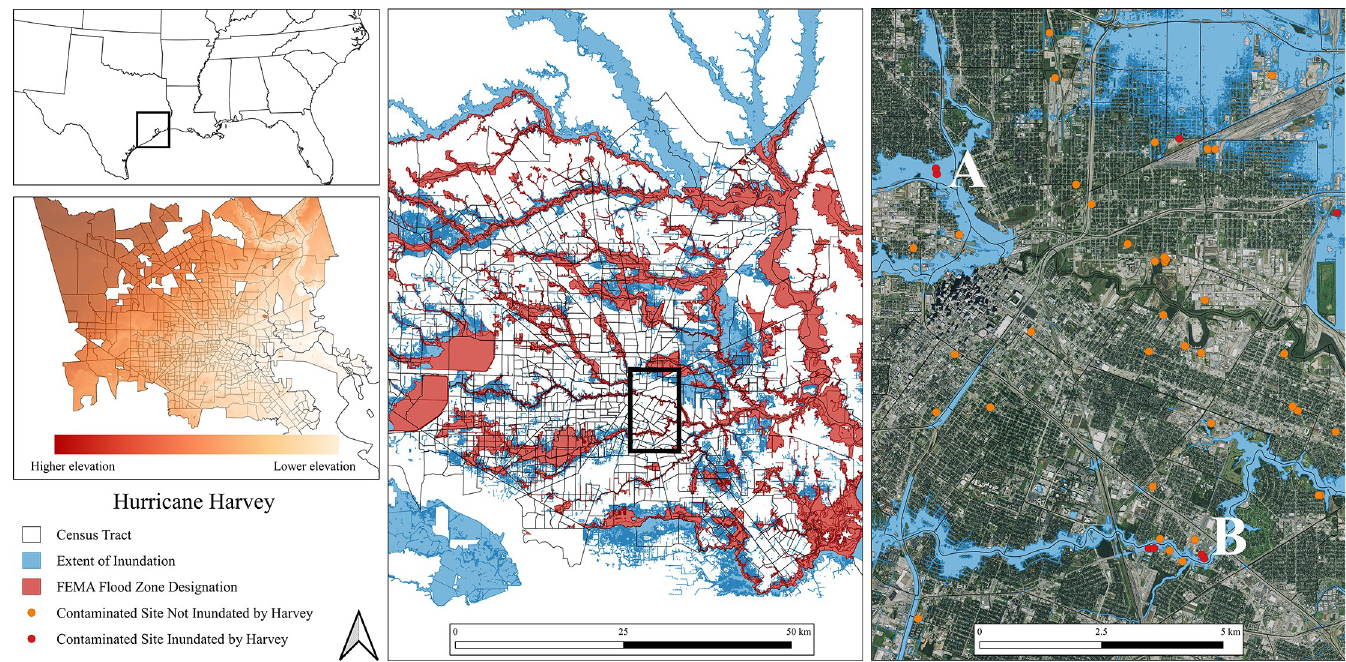
Fig 2. Flooding and inundated contaminated sites during and post-Hurricane Harvey in Houston,